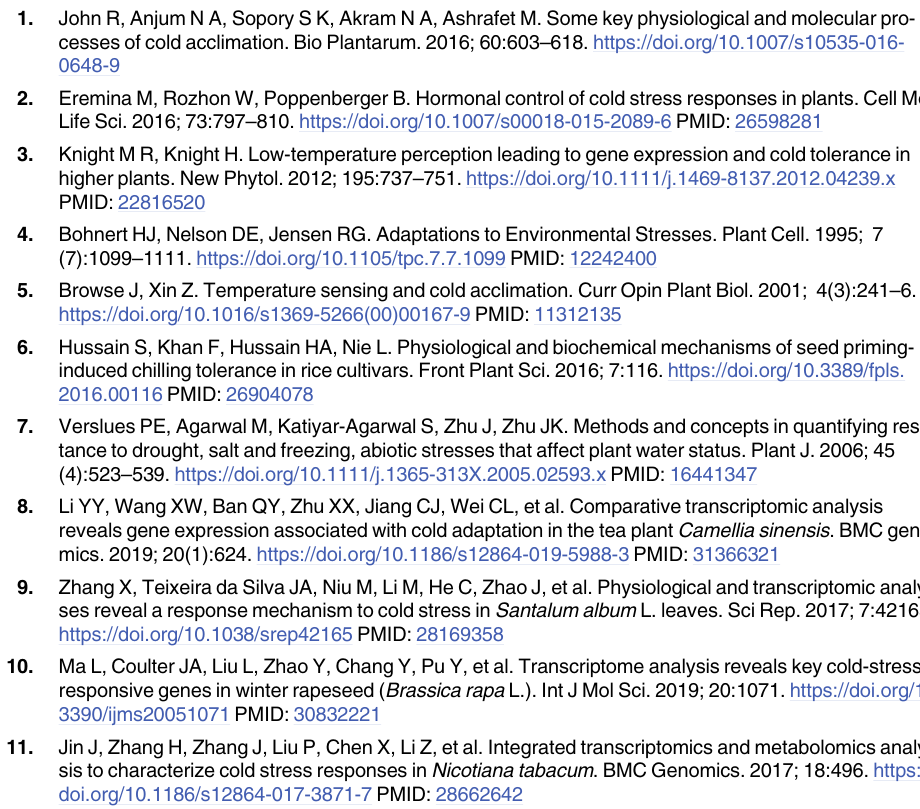
S1 Table. Information of gene specific primers for qRT-PCR. S2 Table. DEGs involving in plant hormone signal